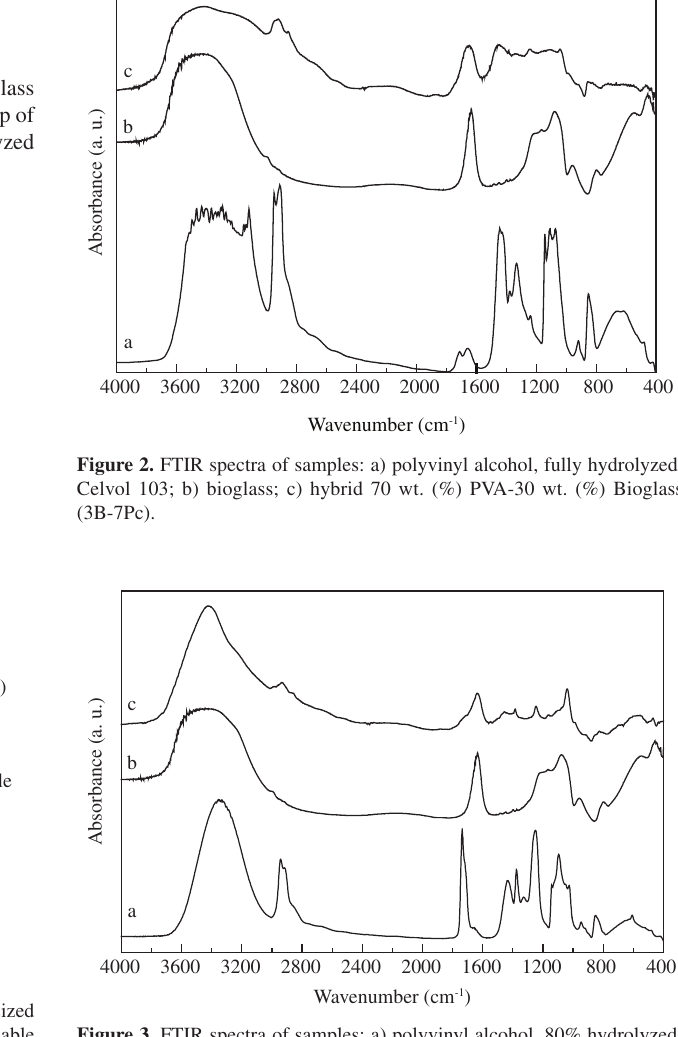
Figure 3. FTIR spectra of samples: a) polyvinyl alcohol, 80% hydrolyzed; b) bioglass; c) hybrid 70 wt. (%) PVA-30 wt. (%) Bioglass